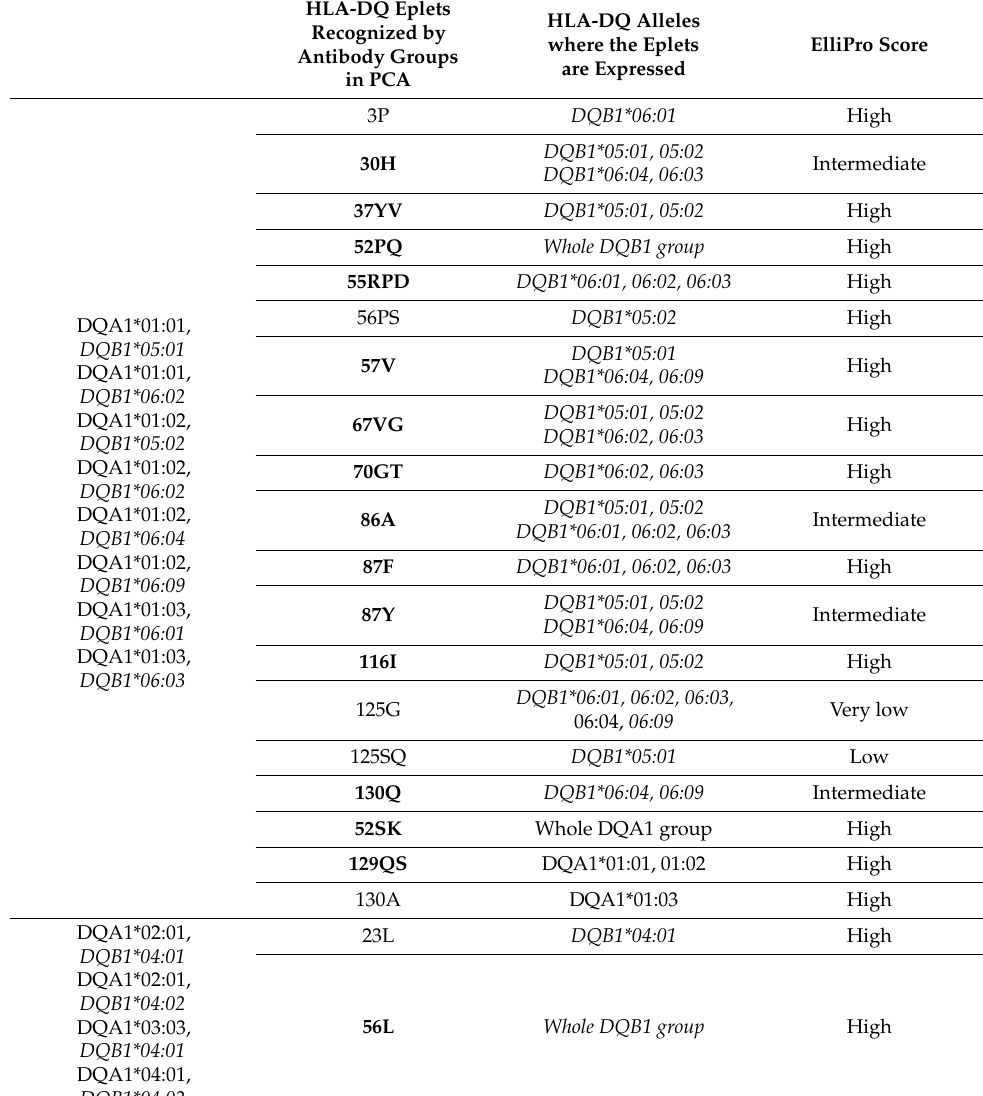
Table 2. Epitopes found exclusively in each of the groups resulted from 1st–2nd and 2nd–3rd plots of PCA and phylogenetic analysis of anti-HLA-DQ responses. It should be noted that the same groups of antibody responses are formed in PCA and the dendrogram. Eplets within each group are listed in the second column. Eplets in bold are those present in more than one allele in each group and have an intermediate or a high Ellipro score. Eplets with very low or low ElliPro scores are considered less likely to drive the respective immune response. The alloresponse appears to be directed against epitopes predominantly expressed on the DQB1allele chain. DQB1 alleles are indicated in italics. HLA-DQ Eplets HLA-DQ Alleles Recognized by where the Eplets Antibody Groups are in PCA